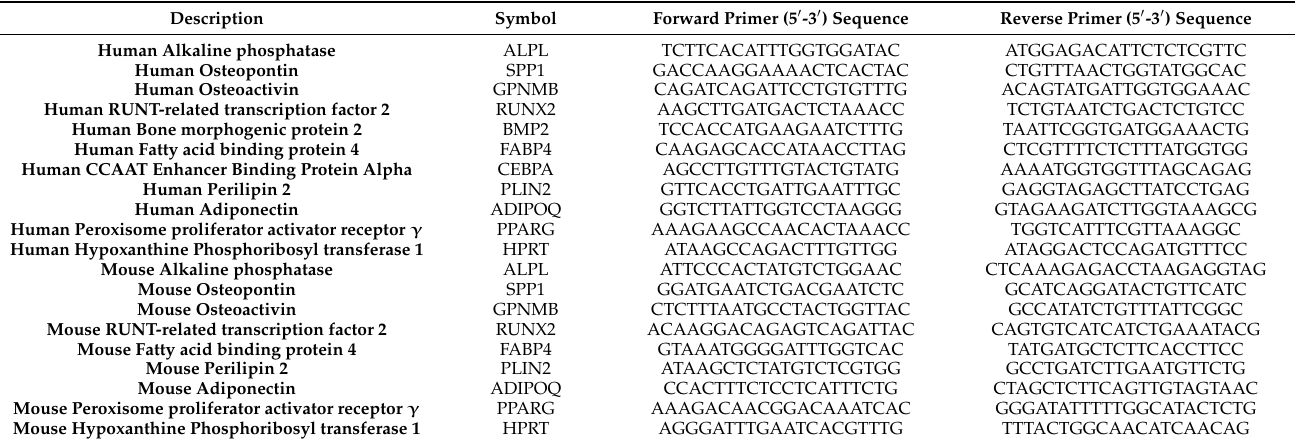
Figure 1. HPRT expression . ( a ) HPRT expression along C3H10T1/2 differentiation measured by Rt-qPCR. ( b ) HPRT expression along hMSC-TERT differentiation measured by RT-qPCR. Table 1. Primers used for RT-qPCR.